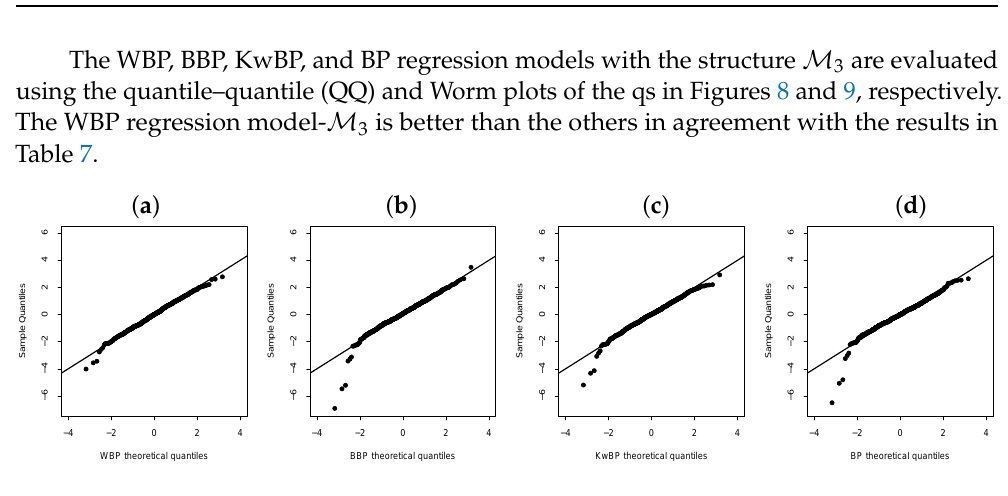
Figure 8. QQ plots of the qrs for COVID-19 data in Campinas from the regression models: ( a ) WBP; ( b ) BBP; ( c ) KwBP; ( d )